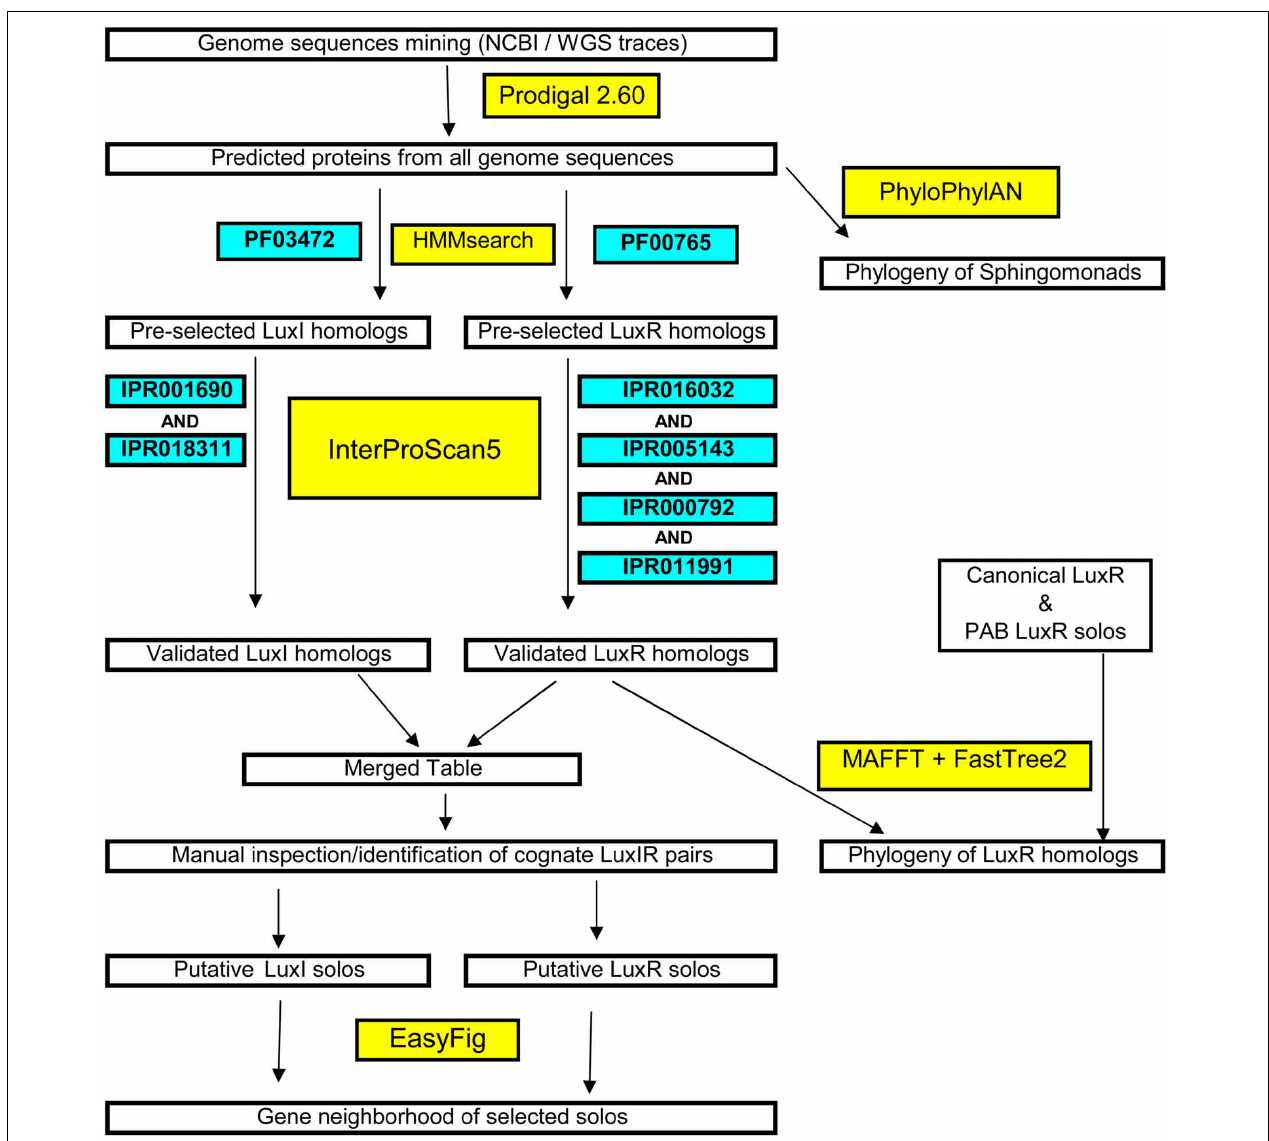
FIGURE 1 | Flowchart of the systematic and stringent bioinformatics methodology used in this study for the identification of luxI/R in sphingomonads and large-scale phylogenetic/phylogenomic tree